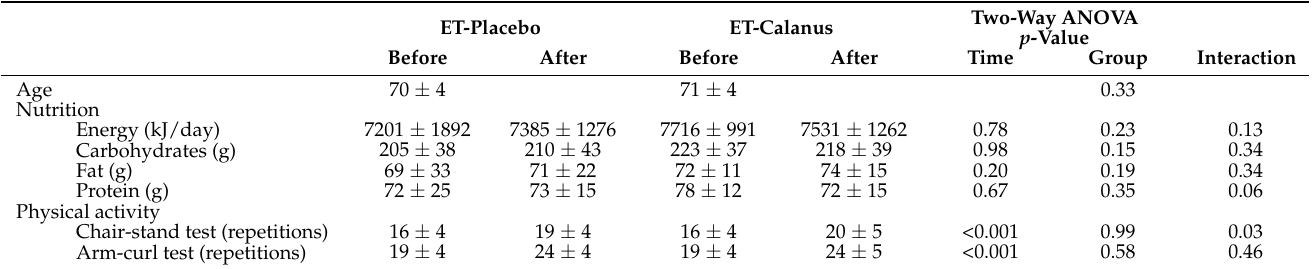
Table 2. Nutritional and physical activity characteristics of the subjects before and at the end of the study. ET-Placebo ET-Calanus Before After Before After Time Group Interaction